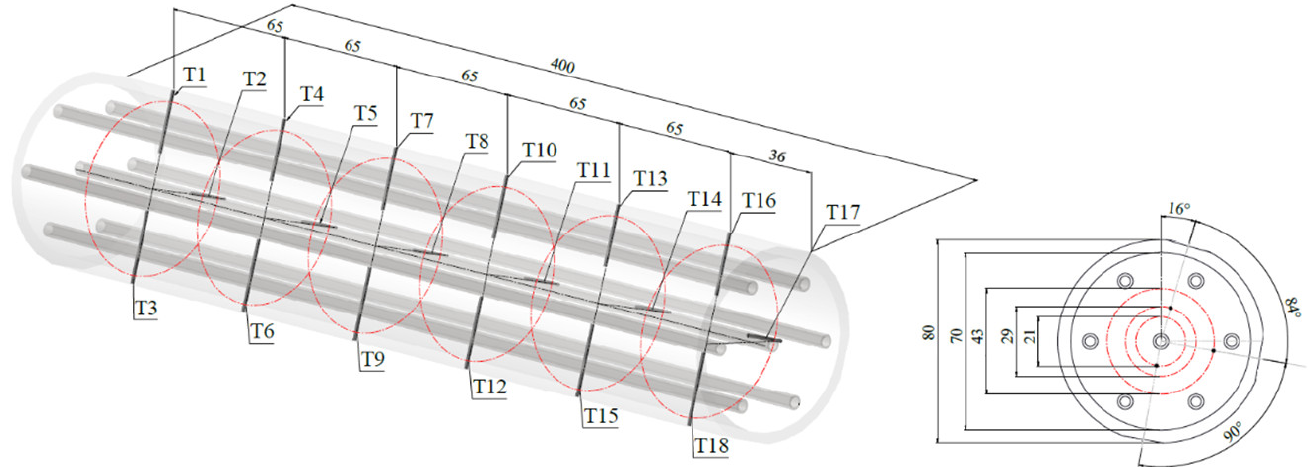
Figure 3. Distribution of PCM temperature measurement points.